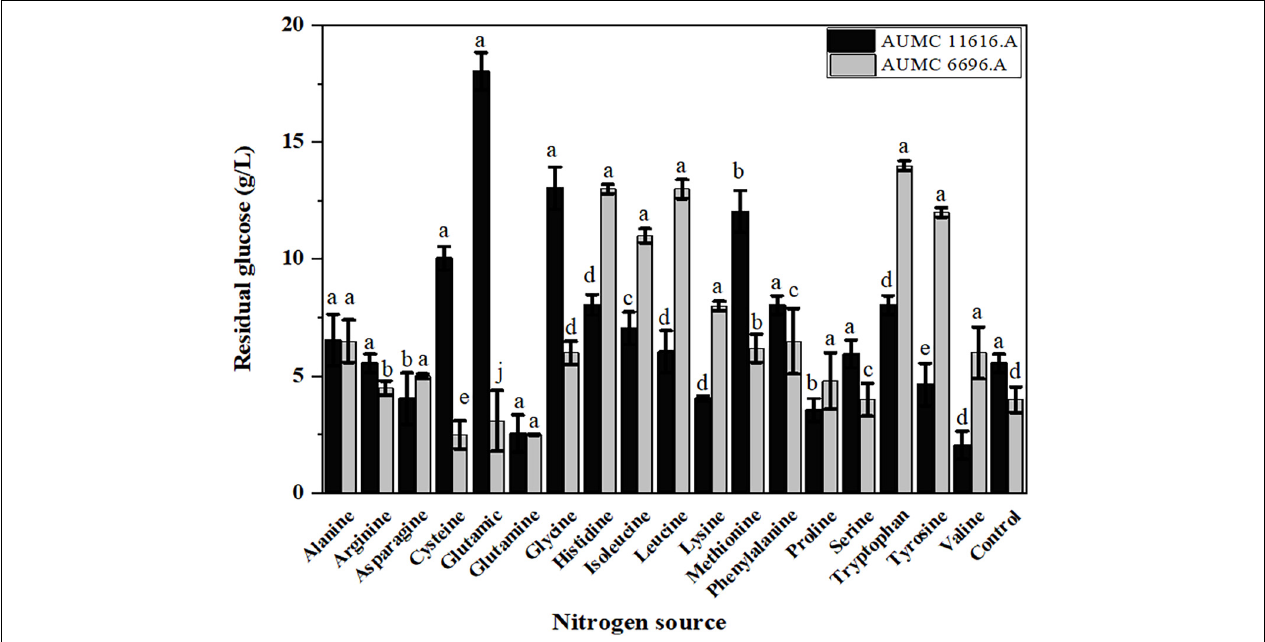
FIGURE 3 | The residual glucose concentration (g/L) of R. pusillus AUMC 11616.A and M. circinelloides AUMC 6696.A strains grown at 30 ◦ C for 4 days, on different nitrogen sources. Ammonium tartrate was employed as the control. Error bars represent the average standard deviation from three biological replicates. Values that show different superscripts were significantly different from each other using t -test ( p < 0.05).